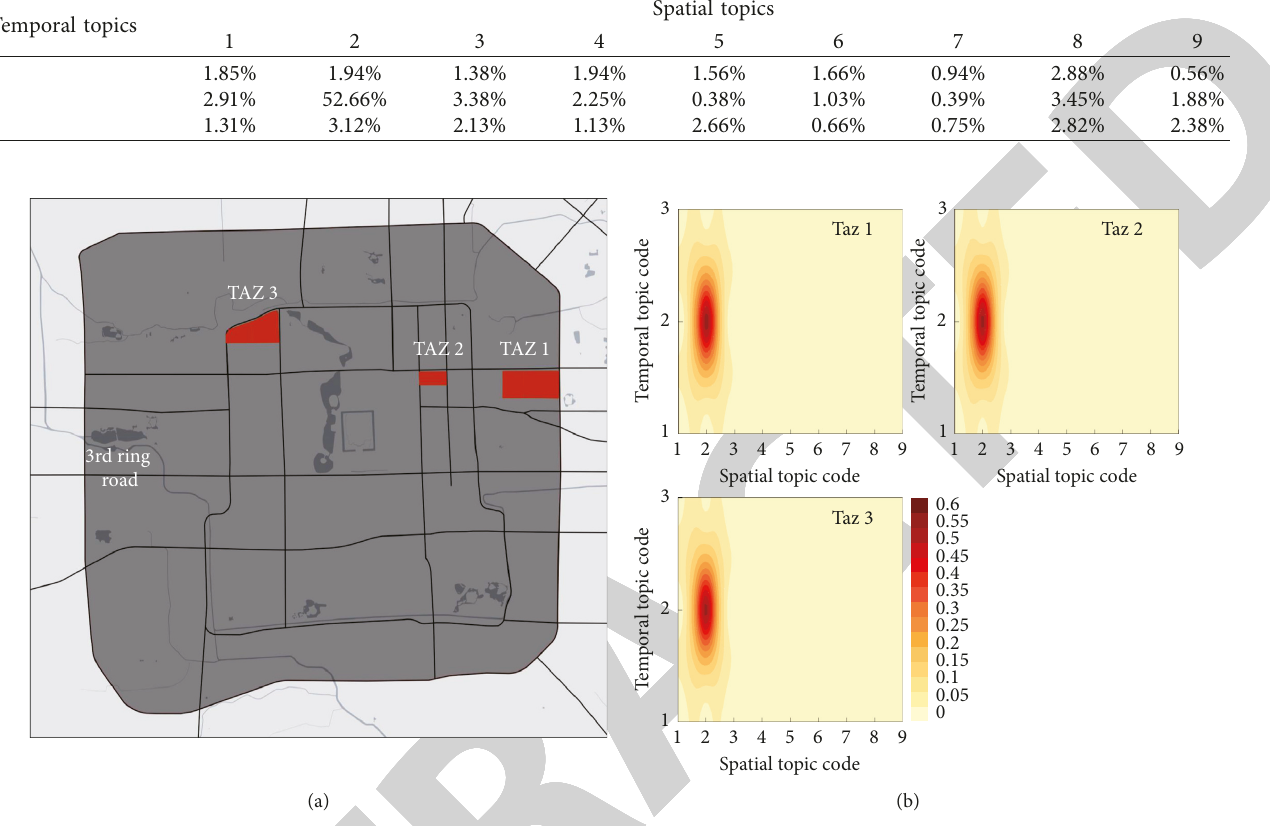
Figure 6: TAZs with similar spatial and temporal topics: (a) spatial distribution of TAZs and (b) probability distributions for the possible